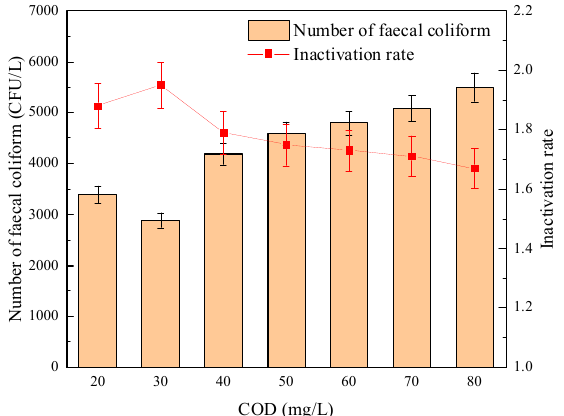
Figure 15. The effect of COD load on the sterilization effect of “Method B”.